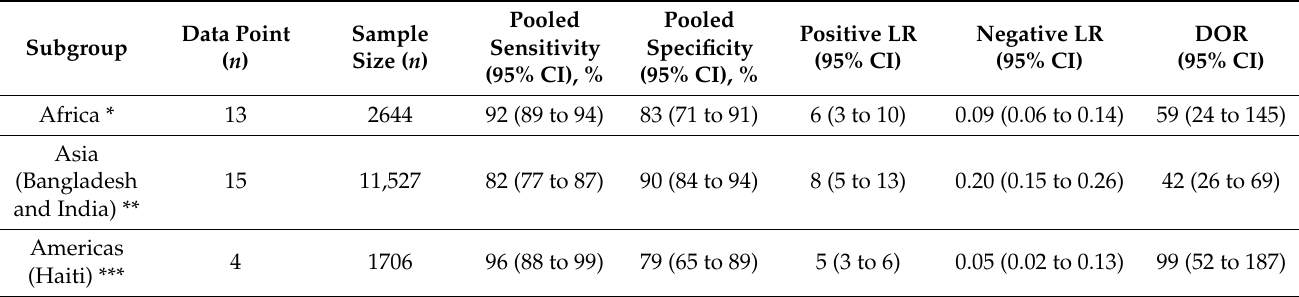
Table 4. Pooled sensitivity and specificity of cholera RDTs stratified by geographical regions.